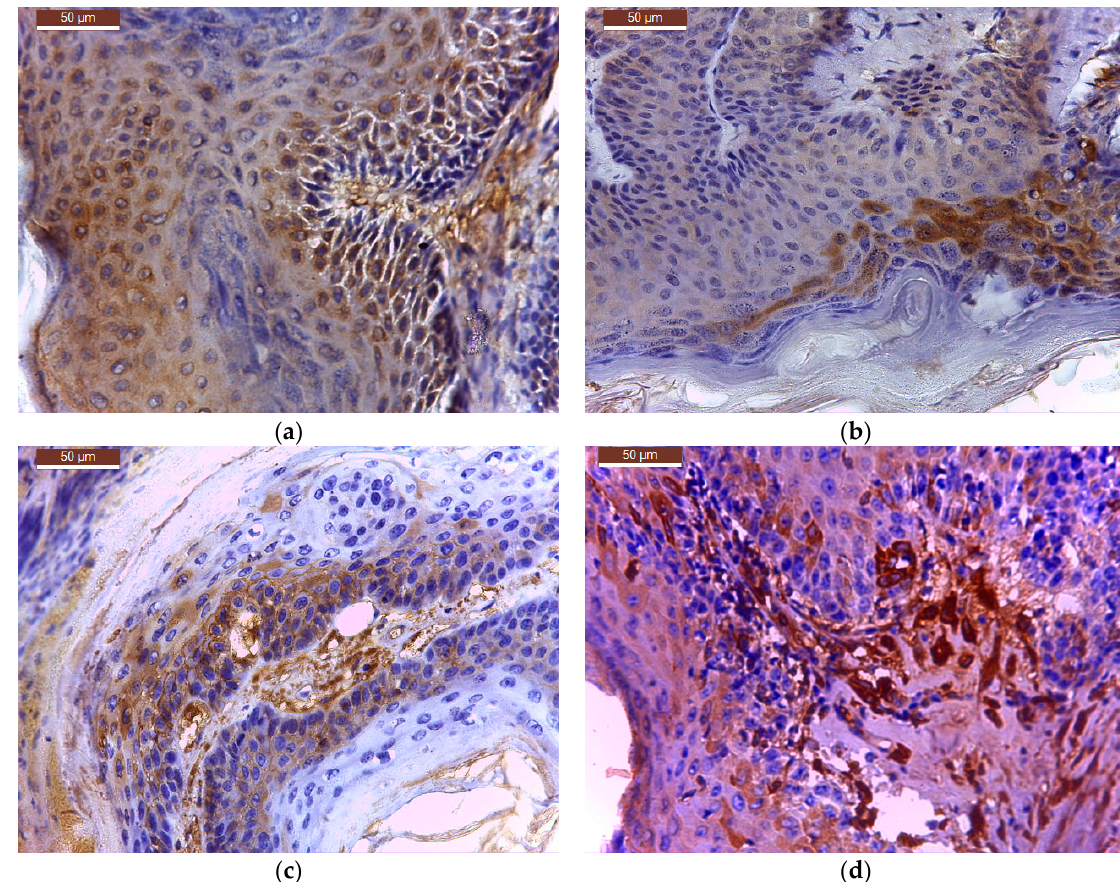
Figure 7. Cox-2 expression in tumour sample treated with: ( a ) C_BCNU@HCLI; ( b ) cream BCNU; ( c ) base cream; ( d ) control saline.